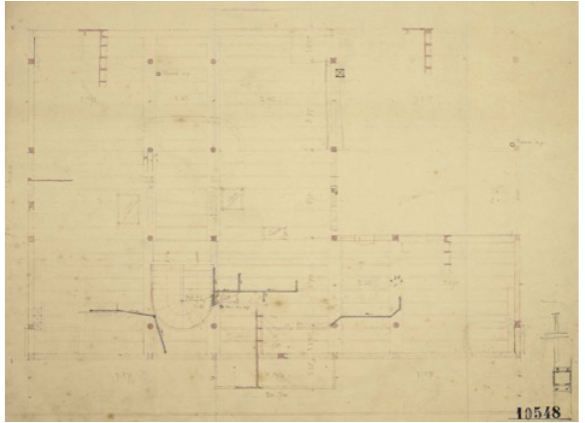
Figure 1. Second floor slab, scale 1:50,